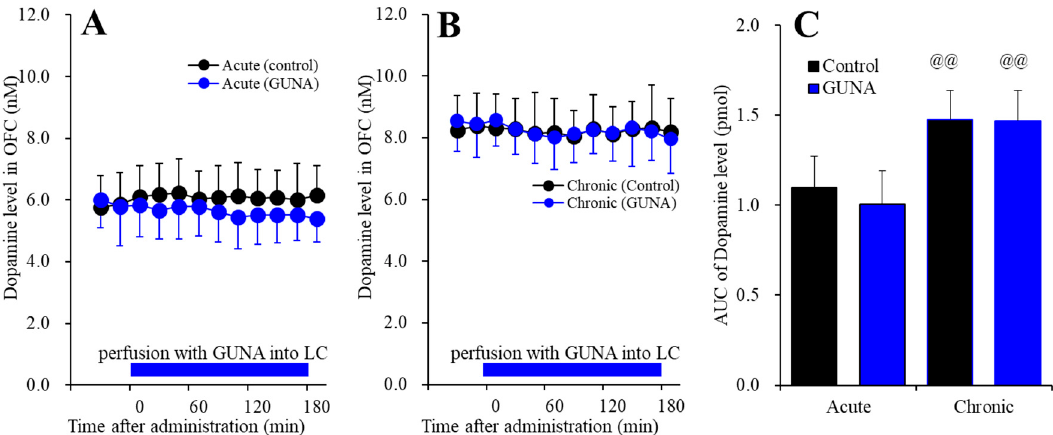
Figure 2. Effects of acute local administration (perfusion with) 200 nM guanfacine into the LC on extracellular dopamine level in the OFC, after the systemically chronic administration of guanfacine (0 or 0.12 mg/kg/day for 14 days). Panel ( A ) indicates the effects of perfusion with 200 nM guanfacine into the LC after chronic administration of guanfacine (0 mg/kg/day) for 14 days (acute effects). Panel ( B ) indicates effects of 200 nM guanfacine after systemically chronic administration of guanfacine (0.12 mg/kg/day) for 14 days (chronic effects). Ordinates: mean±SD (n = 6) of extracellular dopamine level (nM), abscissa: time after administration of perfusion with guanfacine into the LC (min). Blue bars: perfusion of 200 nM guanfacine into LC. Panel ( C ) indicates the AUC 20–180 min values of extracellular dopamine level during perfusion with guanfacine (from 20 to 180 min). Ordinates: mean ± SD (n = 6) of AUC 20–180 min values of extracellular dopamine level (pmol). Black and blue columns indicate respective control and perfusion of guanfacine of AUC values of dopamine levels. When the effects of guanfacine were statistically significant compared using MANOVA, the data were analysed using Tukey’s post hoc test. @@ p < 0.01: compared with acute effects of guanfacine.